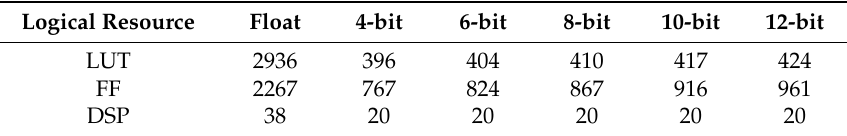
Figure 6. ( a ) Structure of the floating-point-type PE. ( b ) Structure of the hybrid-type PE. Table 1. Logical resource consumptions of PEs in six formats.